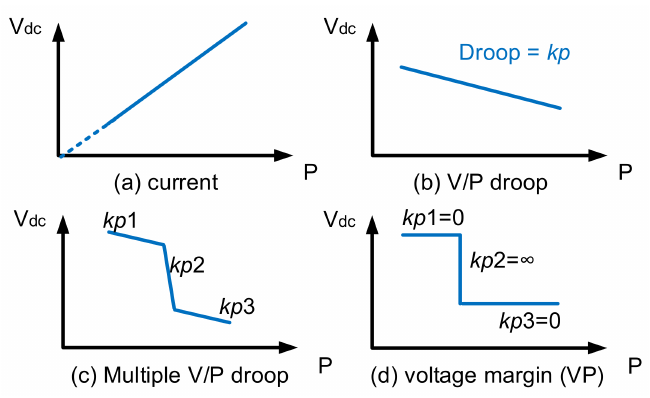
Figure 2. Control characteristics in V-P